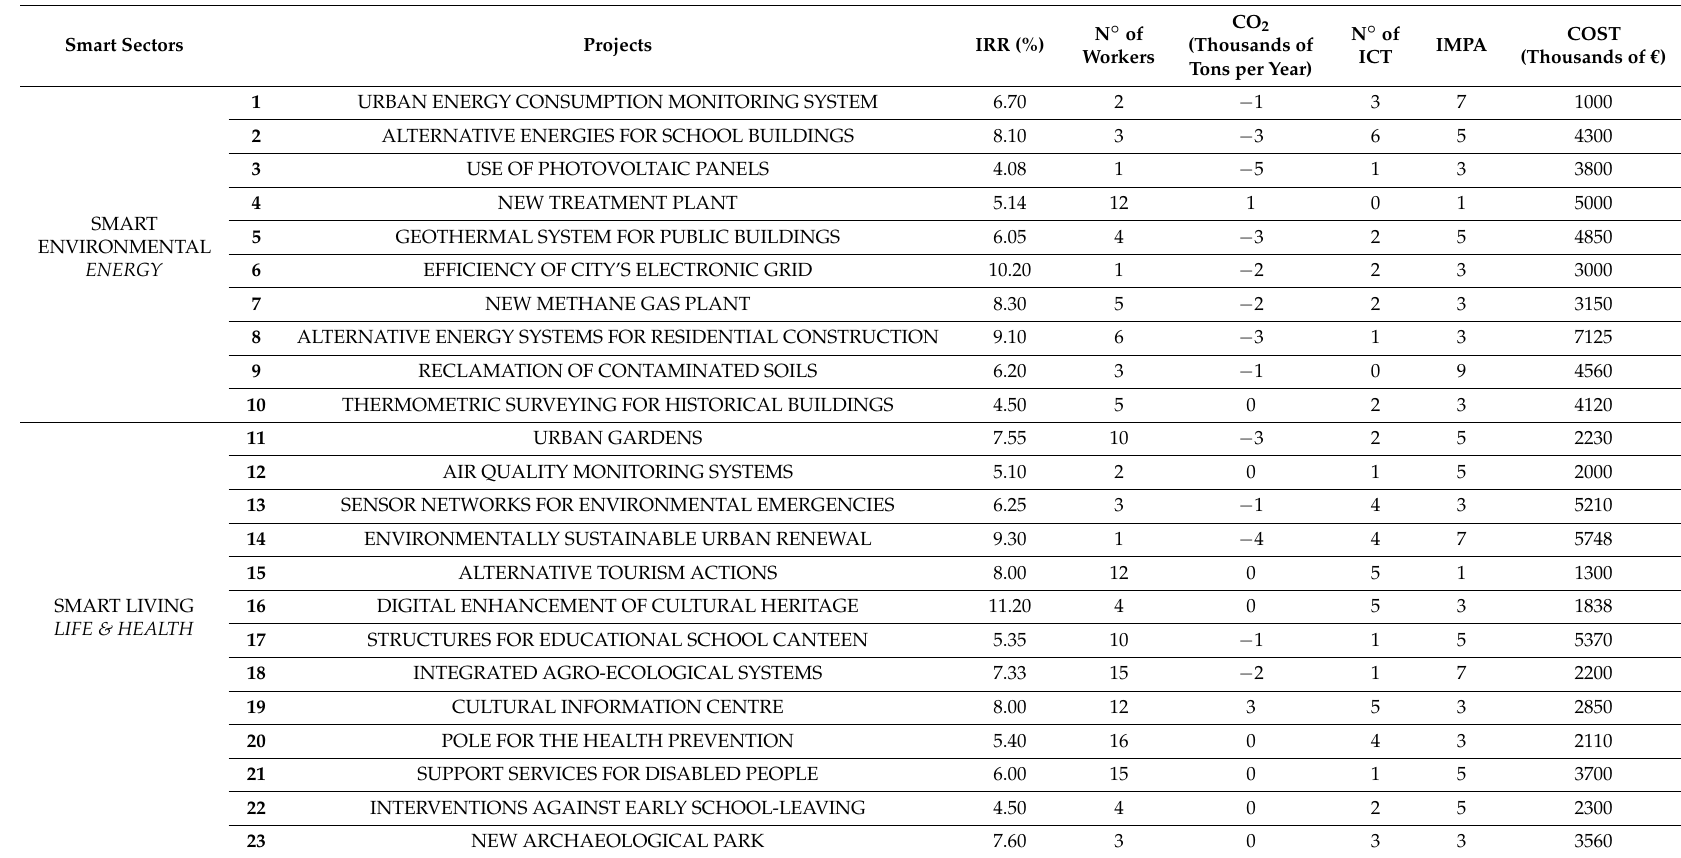
Table 3. Multi-criteria analysis